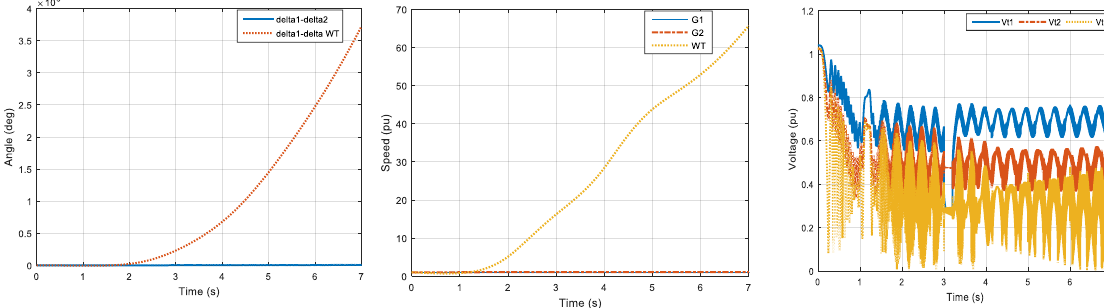
Fig.5. Simulation results with integration of wind